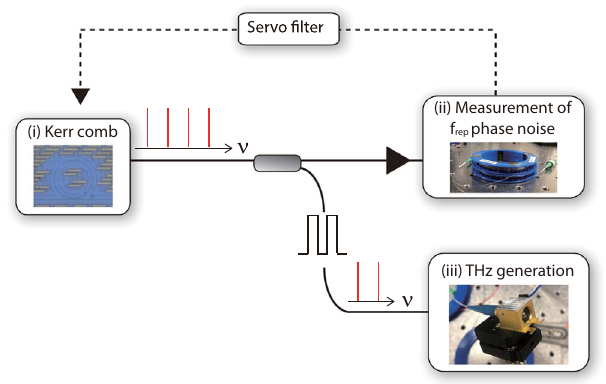
Fig. 1 Conceptual schematic of the generation of a low phase noise THz wave. (i) A Kerr comb is generated from a microresonator. (ii) The phase noise of the f rep of the Kerr comb is stabilized to a long fi ber in a two- wavelength delayed self-heterodyne interferometer (TWDI) through a feedback loop. (iii) The two comb modes of the f rep -stabilized Kerr comb are extracted by an optical fi lter, followed by an uni-traveling-carrier photodiode (UTC-PD) to generate a THz